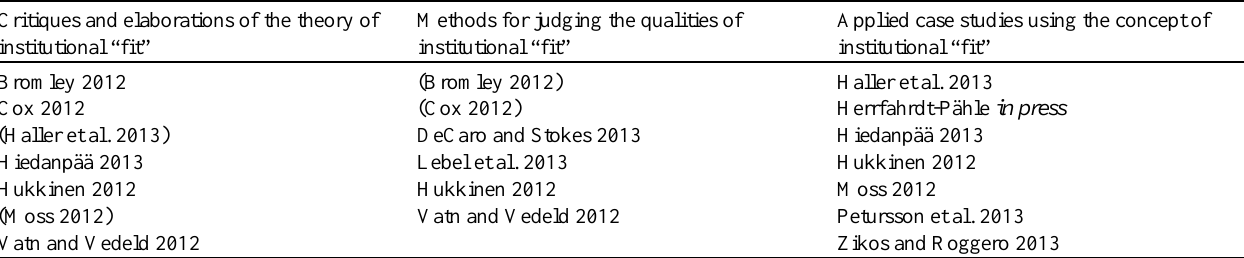
Applied case studies using the concept